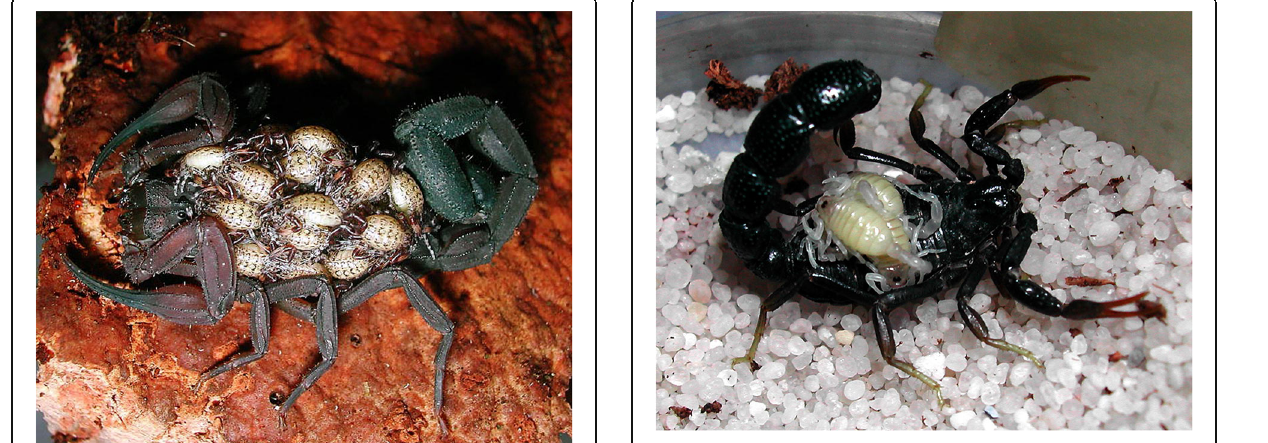
Fig. 14 Female of Orthochirus scrobiculosus from Saudi Arabia with a reduced litter size of first instar pro-juveniles (copyright by Eric Ythier, reproduced with permission)